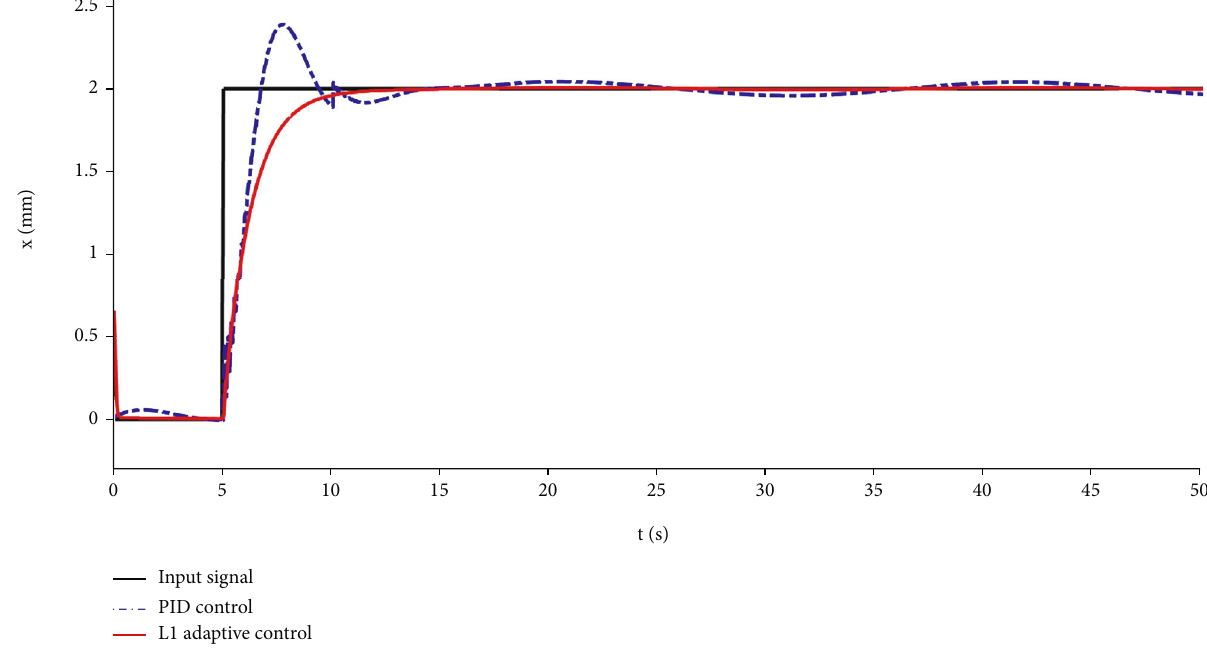
Figure 10: Track signal response during high-frequency disturbances.